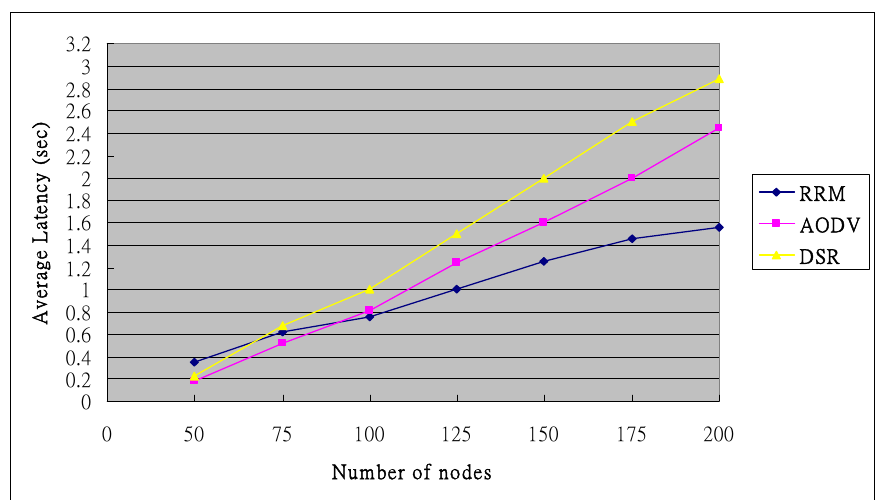
Figure 18. Average